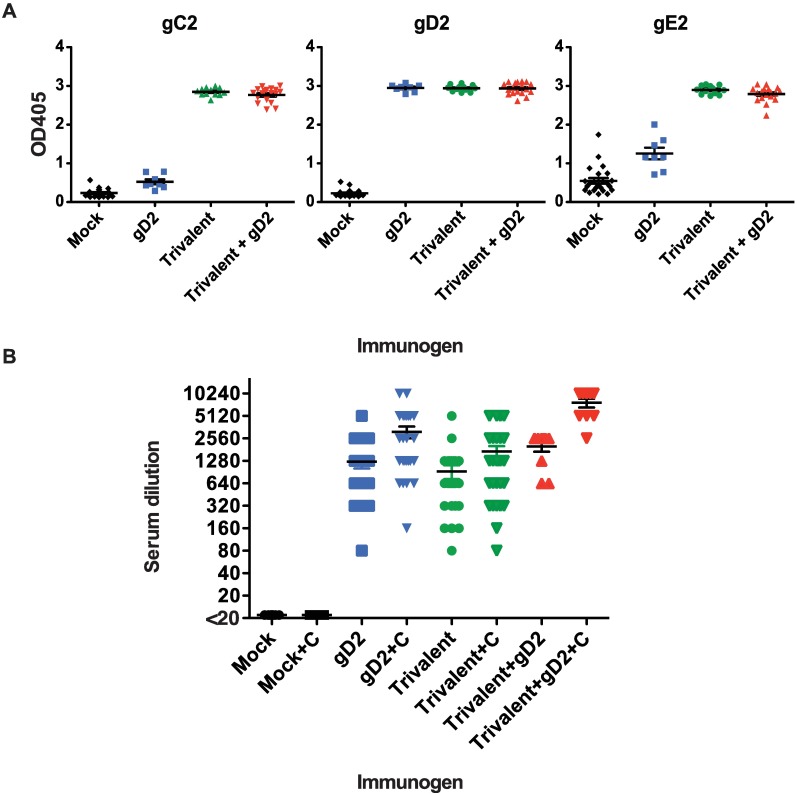
Guinea pig IgG ELISA and neutralizing antibody responses.(A) IgG ELISA titers were measured at a 1:1000 dilution of serum. Samples shown are from the second experiment. P values were calculated using Fisher’s exact test. (B) Serum neutralizing titers with and without complement. Samples evaluated were obtained two weeks after the final immunization from animals in the first and second experiments. P values within groups comparing with and without complement were calculated by Student’s t-test, while comparisons between groups were done using the Mann Whitney test.